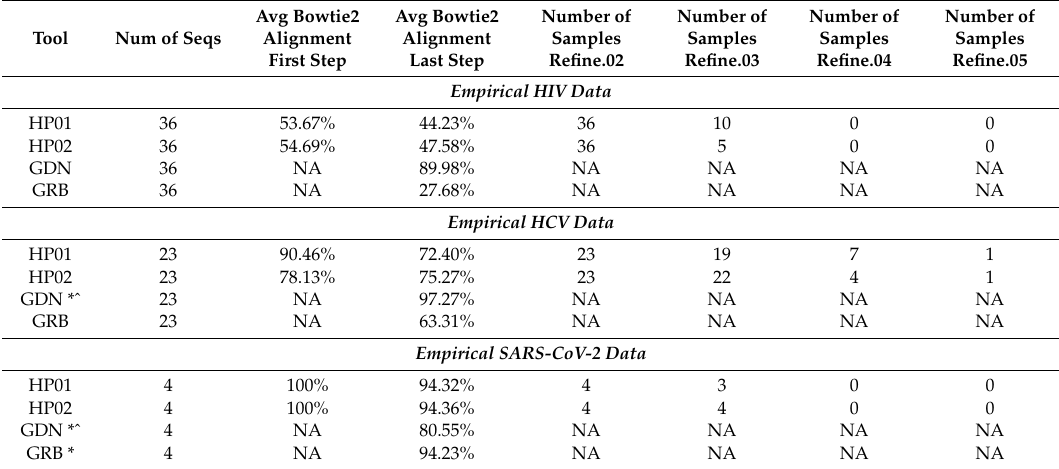
Table 3. Comparison of the e ff ect of consensus generation on estimated genetic diversity across the empirical